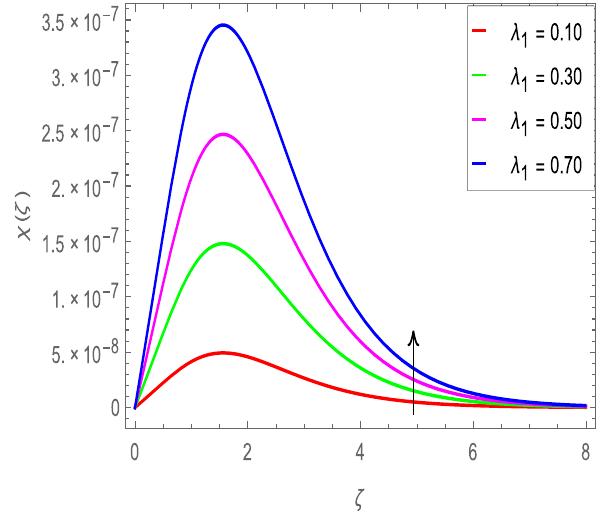
Figure 20. χ(ζ) in terms of (cid:31) 1 .